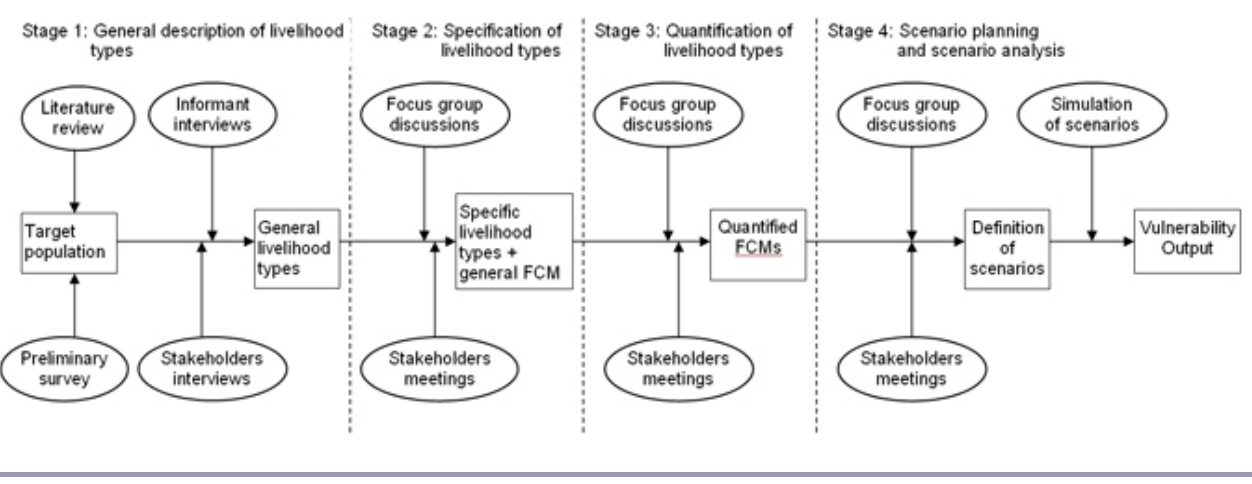
Fig. 2. Four main stages of the research process that was used to understand the vulnerability of different rural livelihoods to hazards in southeastern Zimbabwe. FCM = fuzzy cognitive